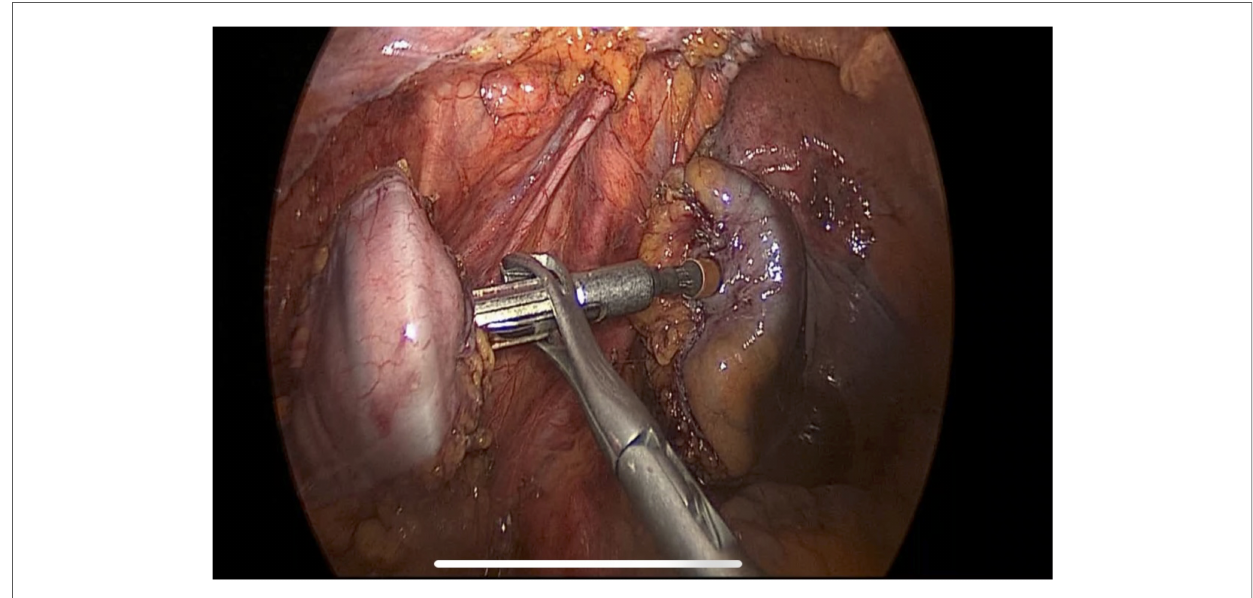
FIGURE 2 Knight – Griffen colorectal